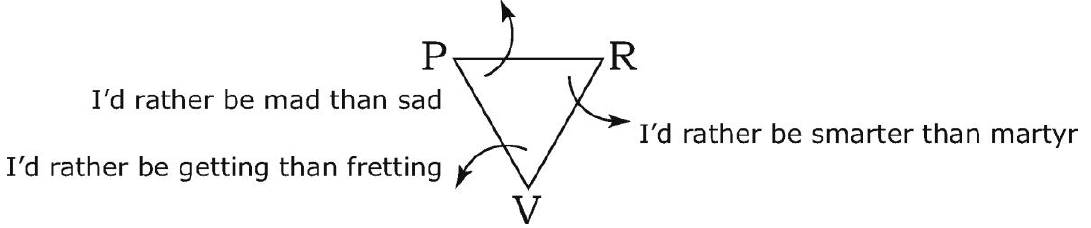
Figure 4: The Escapes Drama